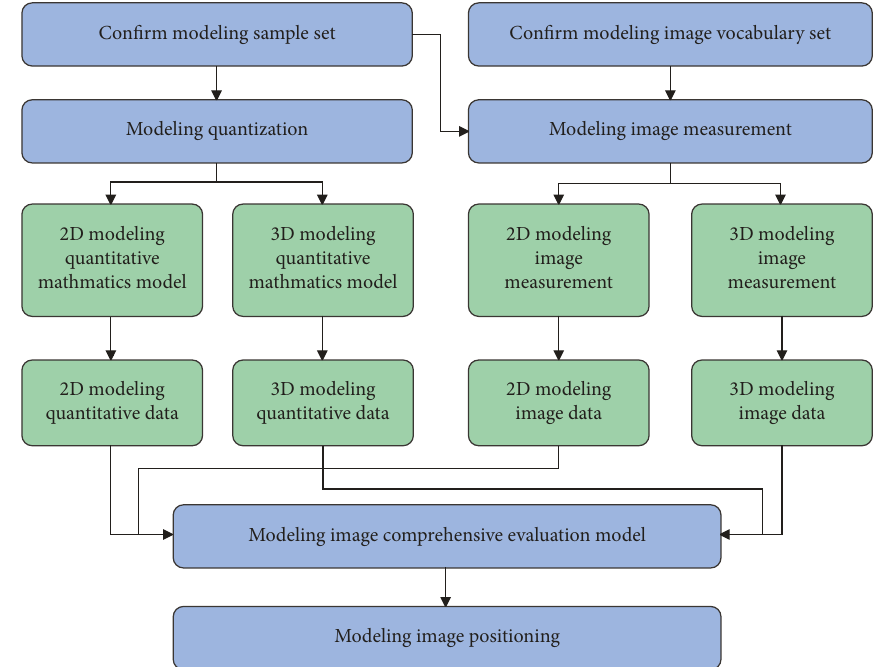
Figure 6: The positioning process of ceramic art product modeling image.